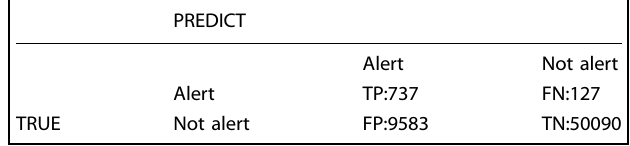
Table 8. Confusion matrix of fi nal model on second fold validation set.